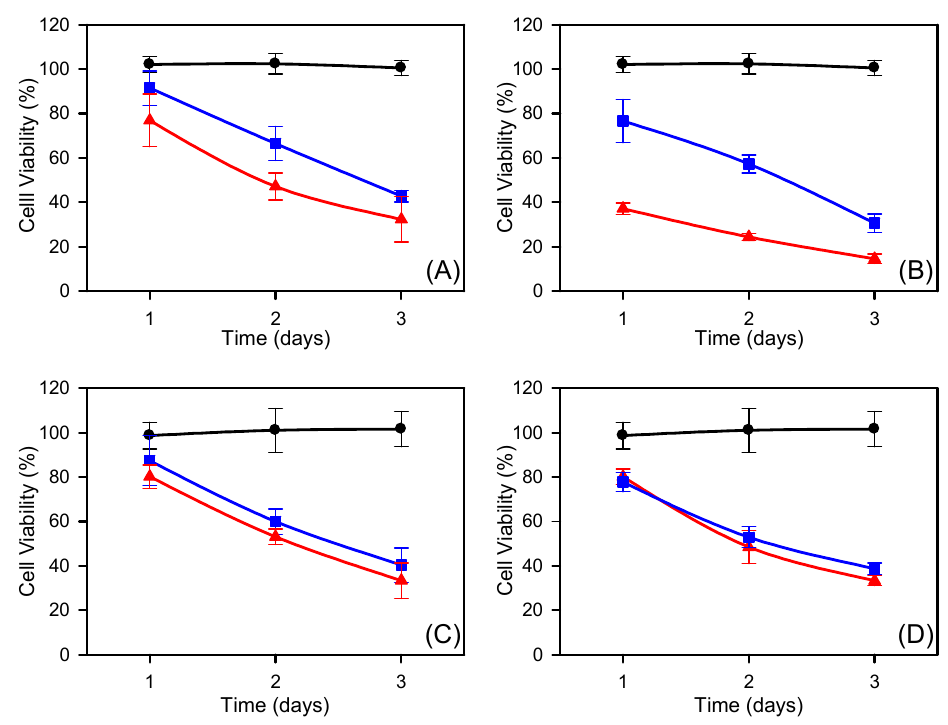
Figure 5. Cytotoxicity of 5-fluorouracil-loaded folate-conjugate submicrogels (F-SubMGs). Cell viability of MCF7 ( A , B ) and HeLa ( C , D ): in the presence of 10 μ M ( A , C ) and 50 μ M ( B , D ) of 5-fluorouracil (5-FU): Without drug ( ● ); 5-FU in solution ( ■ ); 5-FU-loaded F-SubMGs ( ▲ ). Data were shown as mean±SD ( n